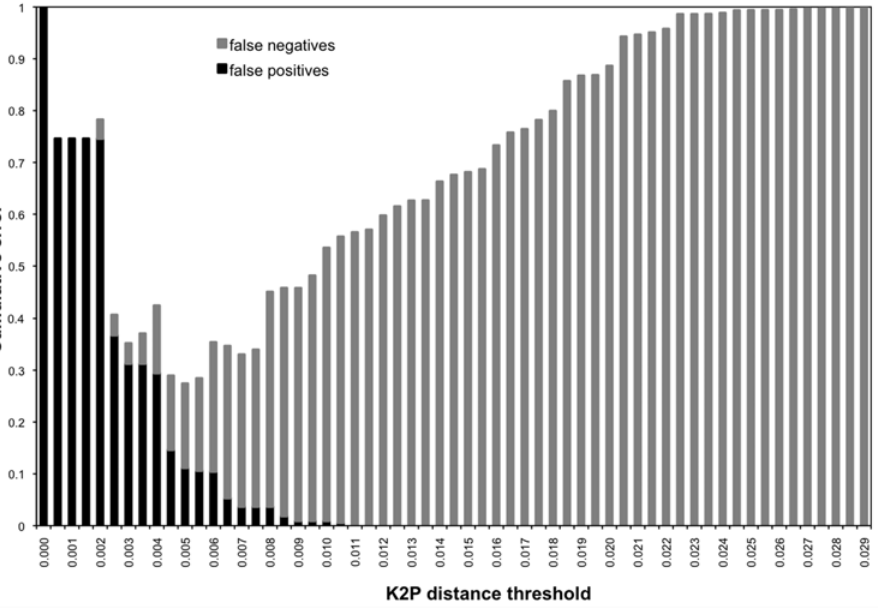
Figure 3. Cumulative error for committing false positives and false negatives with 87 reference samples according to K2P distance thresholds. Error was minimized at 27% at D K2P =0.005.